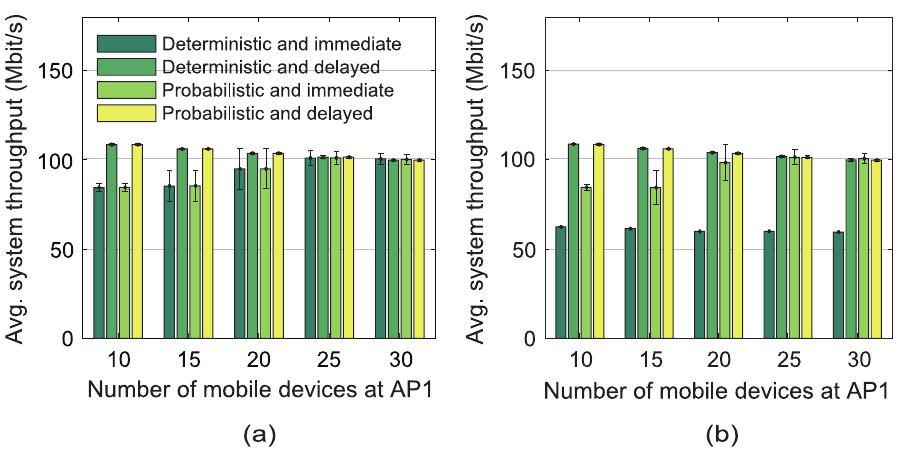
Fig 15. Average system throughput versus the number of mobile devices associated with AP1. When the number of APs whose performance was collected was (a) 2 (i.e., unsaturated learning) and (b) 5 (i.e., saturated learning).